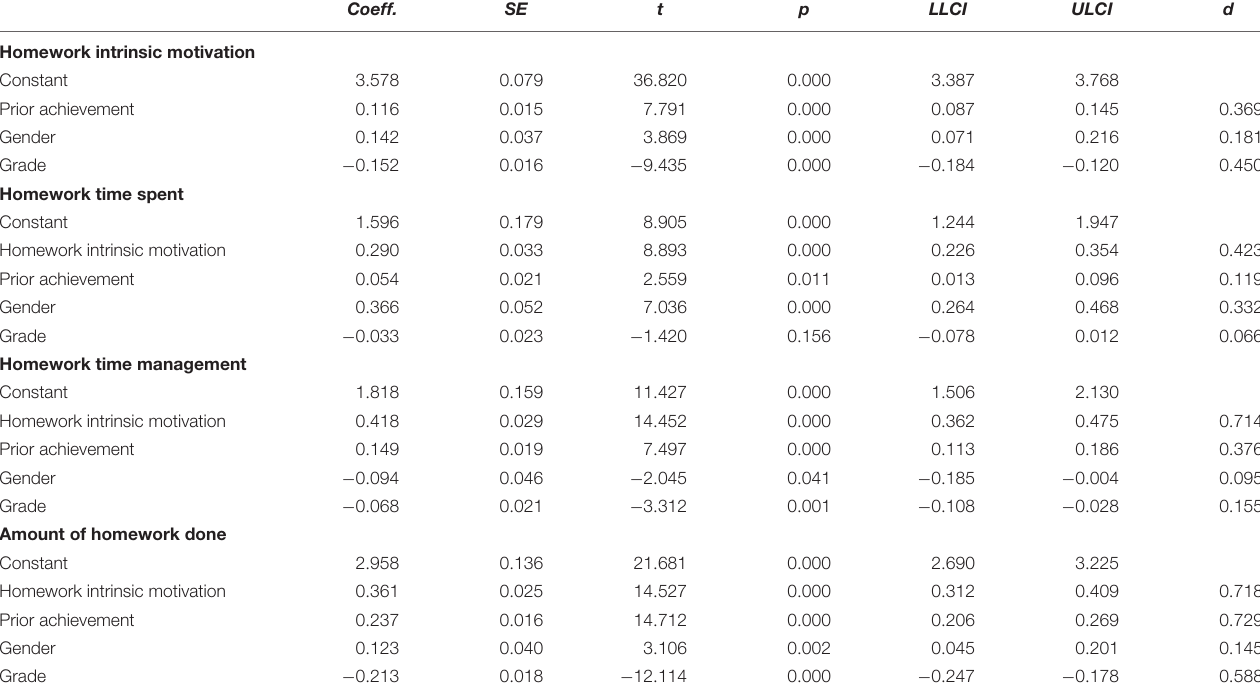
TABLE 2 | Summary of the mediation model.